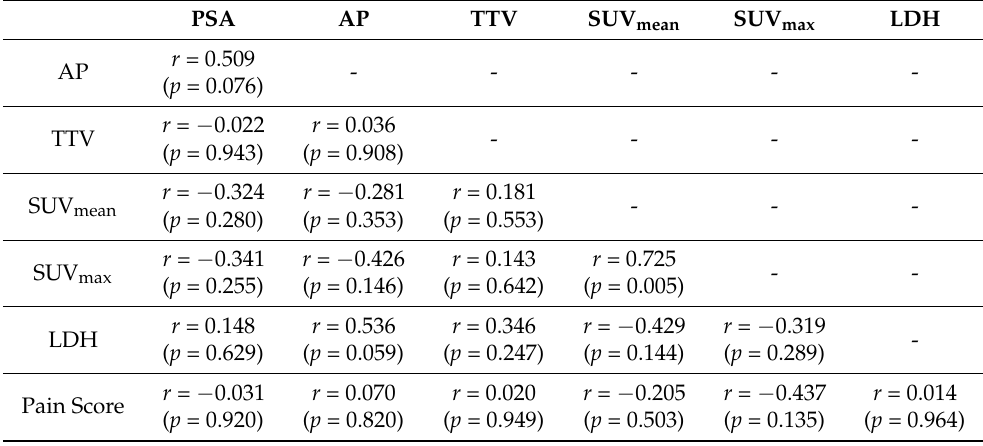
Table 2. Correlation of clinical and image-derived parameters prior to the first cycle of 225